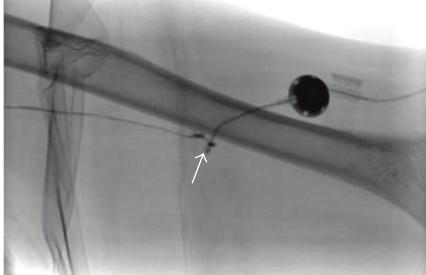
Figure 2: Contrast has been injected into the port. A small amount of contrast is seen to extravasate at the end of the residual catheter situated at the arm vein entry site (arrow). The contrast then flows freely into the patent, residual, fibrin sheath in the basilic vein related to the embolized